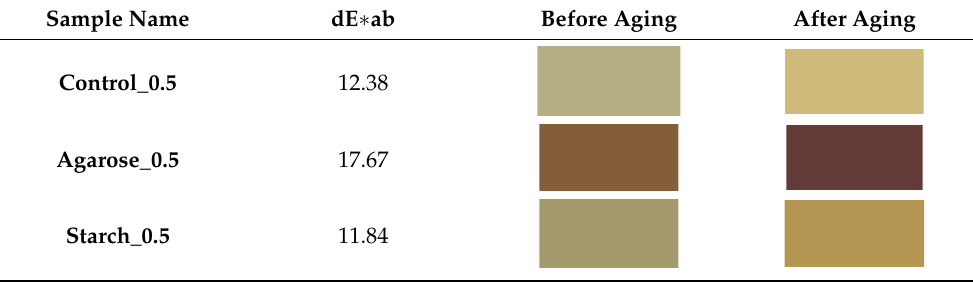
Table 5. Analysis of color changes after thermo-oxidative aging.